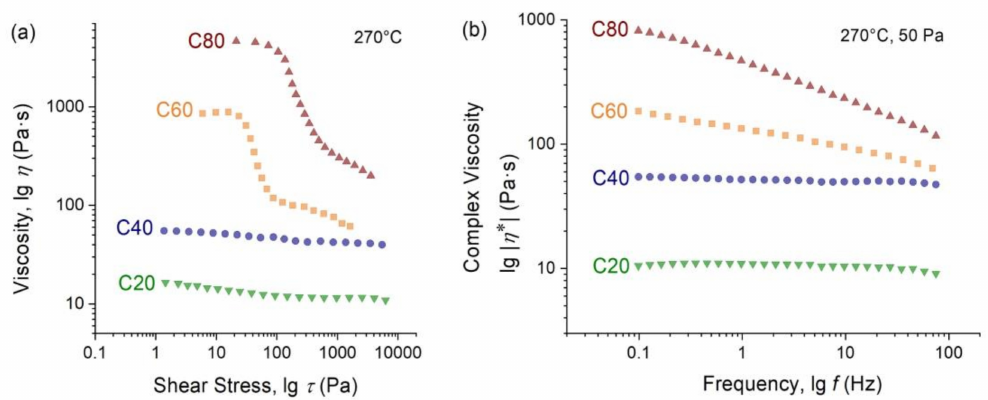
Figure 7. Flow curves of C20–C80 copolyester melts obtained at stationary shear ( a ) and oscillation ( b ) modes at 270 ◦ C. Table 6. The values of the melt viscosity of C20–C80 copolyesters measured in the stationary shear ( η ) and oscillation (| η *|) modes at equal shear rates (